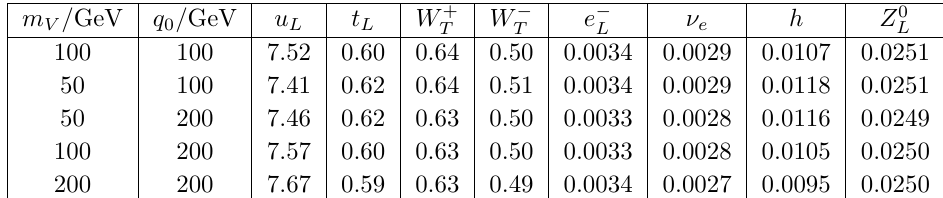
Table 3 . Momentum fractions (%) carried by various parton species at scale q = 100 TeV.